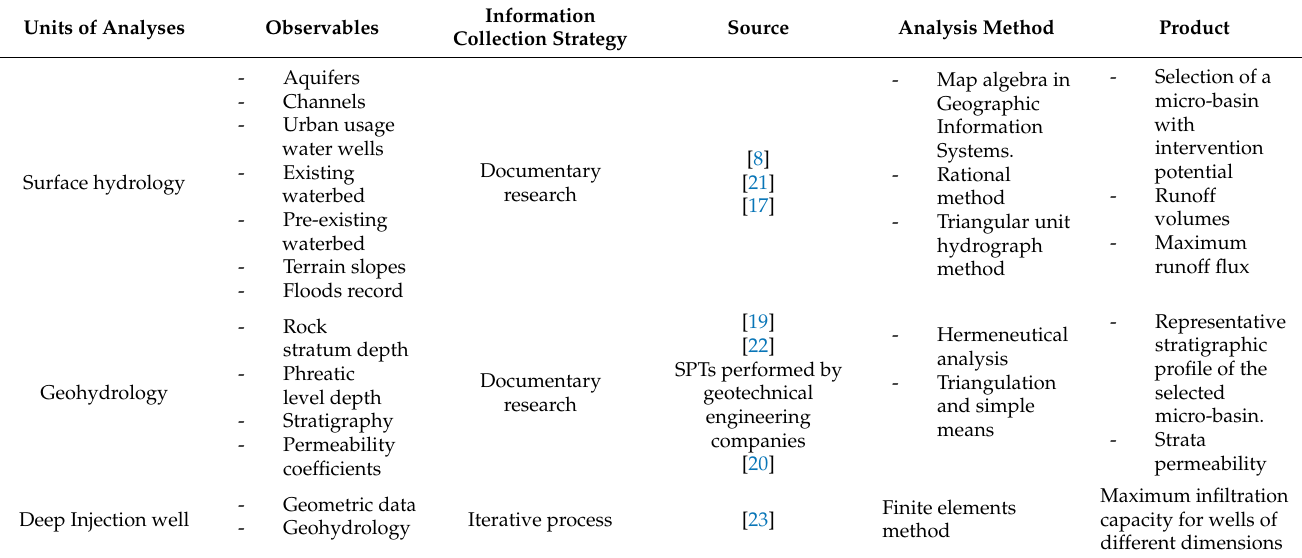
Table 1. Analyses elements and data gathered for the